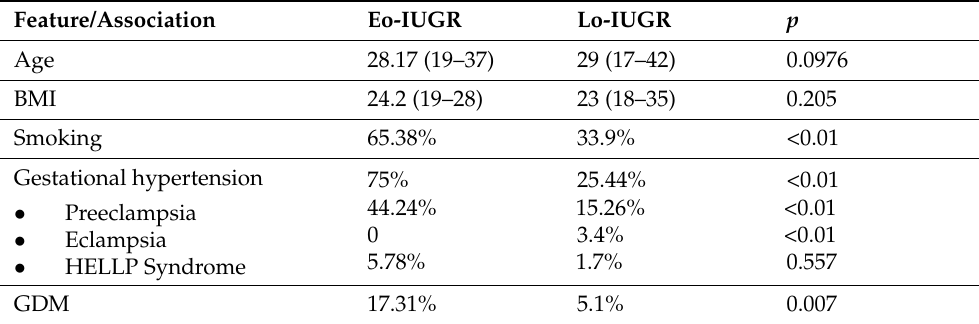
Table 1. General maternal characteristics and main associations in pregnancies complicated with early- and late-onset IUGR.